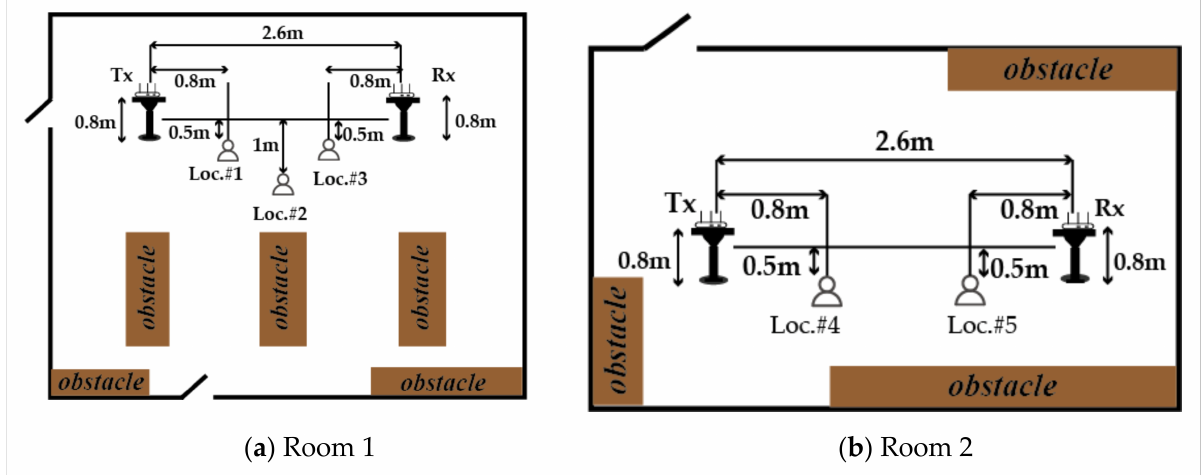
Figure 2. The layout of two different indoor environments: ( a ) Room 1; ( b ) Room